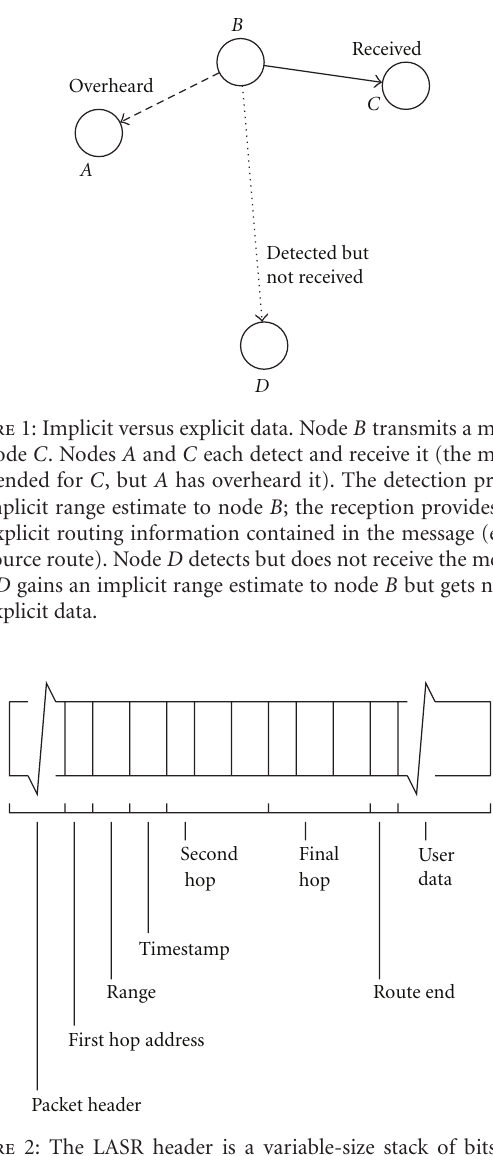
Figure 2: The LASR header is a variable-size stack of bits. This shows the source route portion of a three-hop